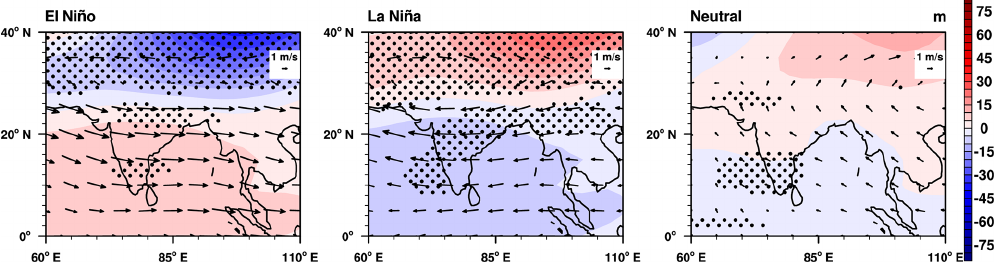
Figure 9. Anomaly composite of geopotential height at 500 and 200hPa wind during different ENSO phases. The stippling indicates statis- tically significant areas of geopotential height at a 95% confidence